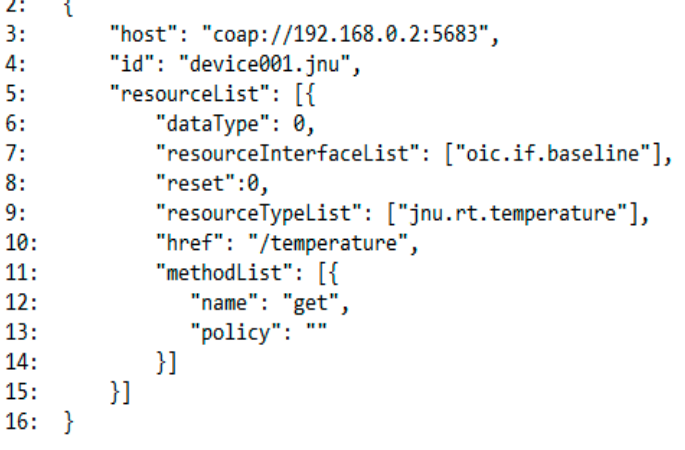
Figure 3. The IoT device registration resources.